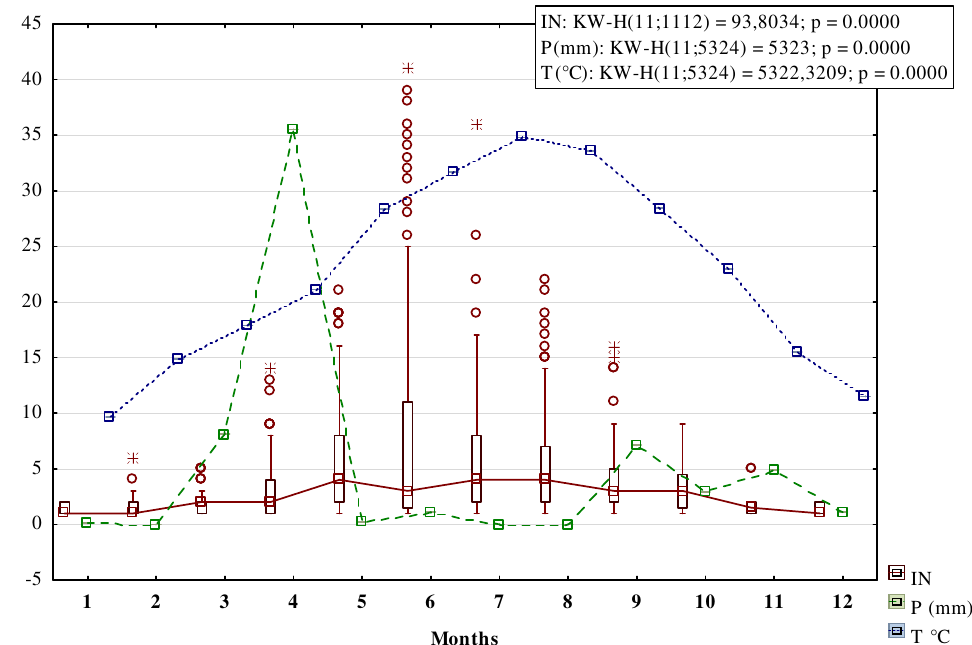
Figure 4. Individuals number of ectoparasites depending on months Individuals number of ectoparasites in black rats’ sexes depending on